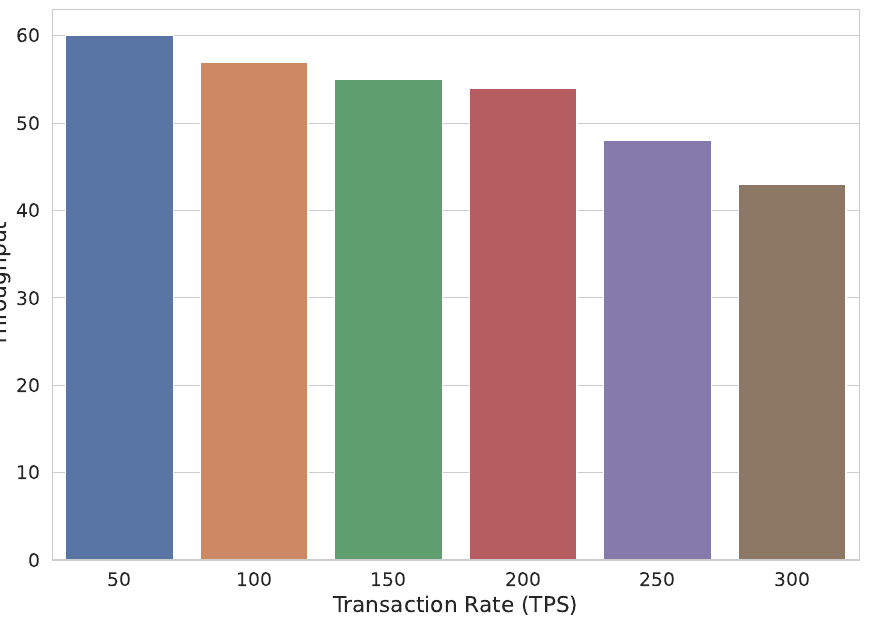
Figure 17. Transaction throughput with varying transaction rate.